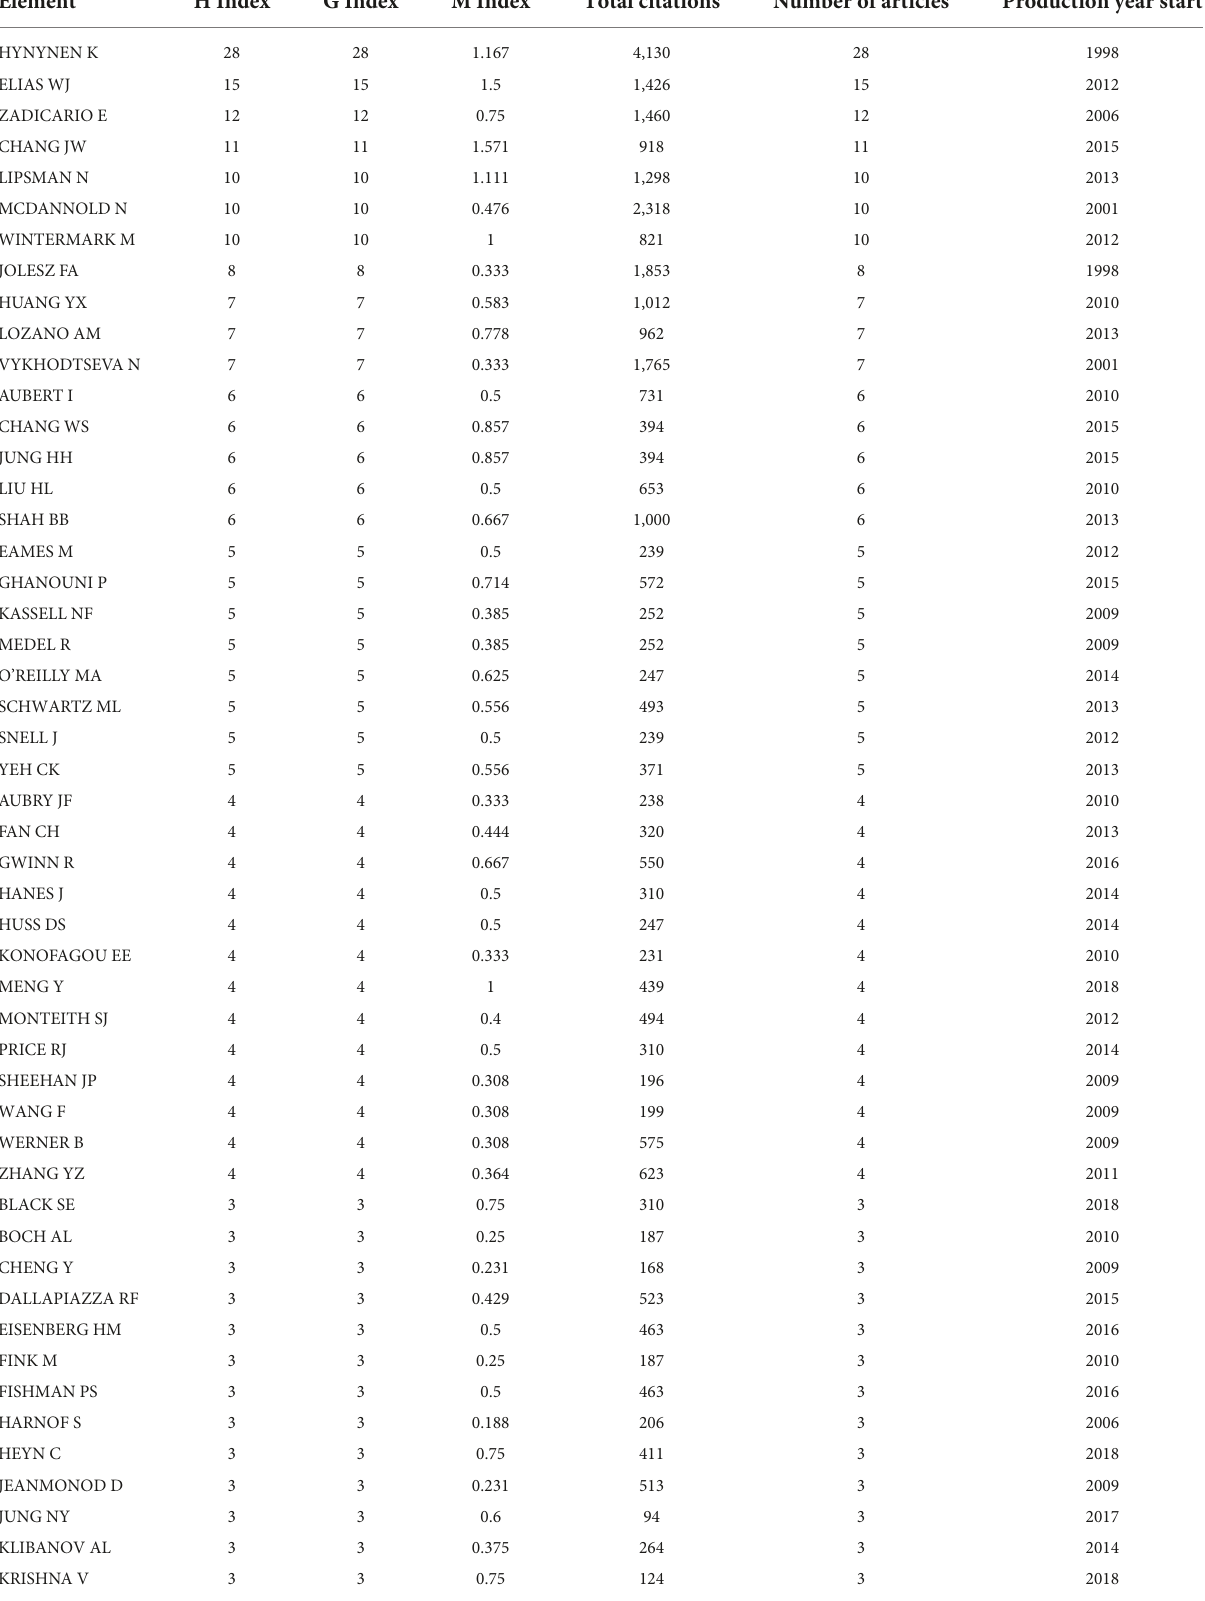
TABLE 3 Various indexes of the top 50